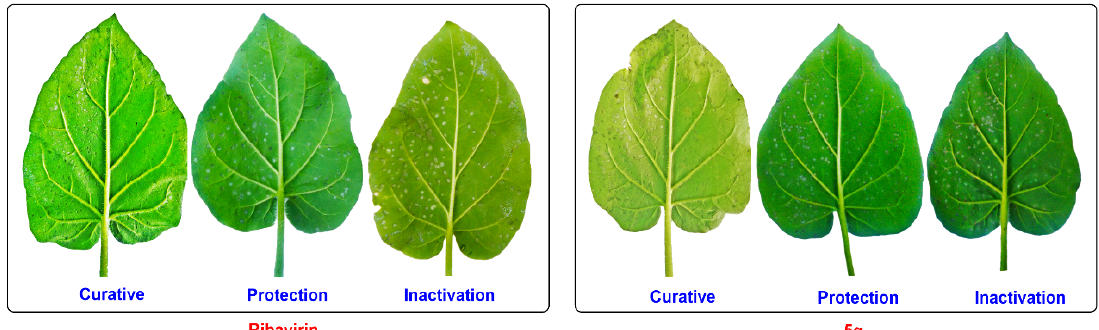
Figure 2. Tobacco leaf morphology effects of the RBV and 5g against TMV in vivo. (Left leaf: Not treated with compound, right leaf: Smeared with compound).